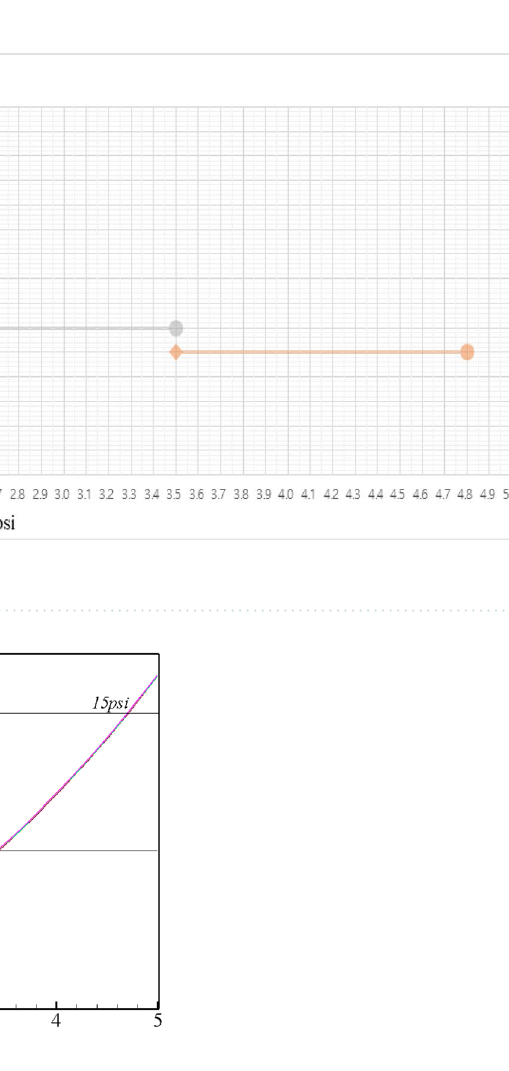
Figure 2. Range of flow rate and pressure for 19 gauge.